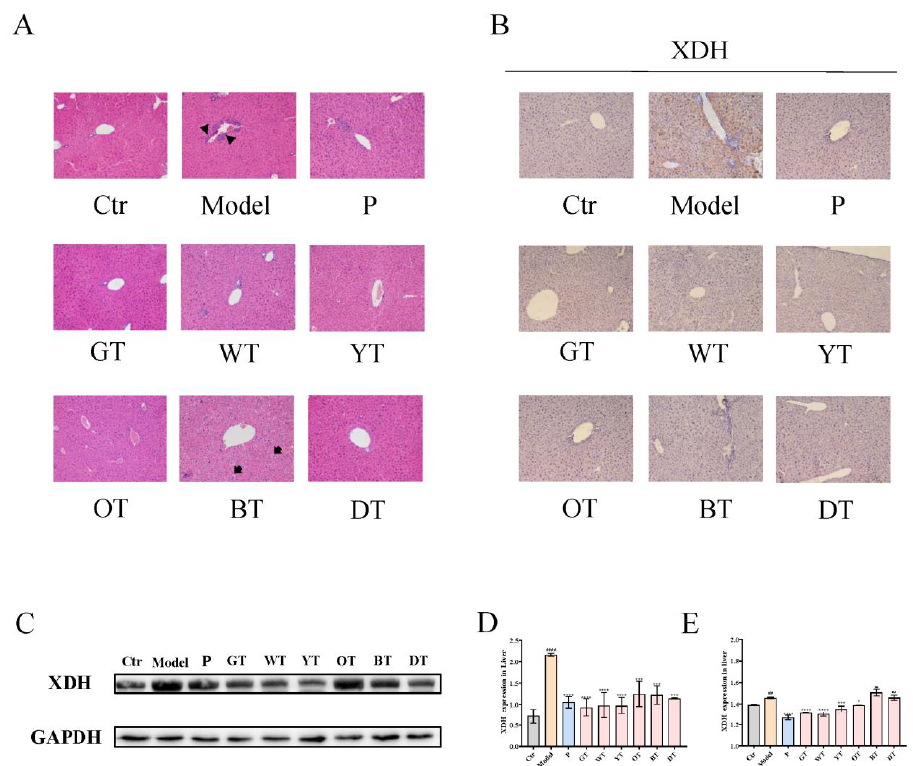
Figure 2. Mechanism of TWEs on UA metabolism in the liver. ( A ) Representative H&E-stained liver tissue images of different treatment groups: triangles indicate inflammatory infiltration and arrows indicate vacuolar degeneration of hepatocytes (200×). Representative IHC ( B ) and Western blotting ( C ) images of XDH expression in the liver. Quantification of XDH expression by Western blotting ( D ) and IHC ( E ). The data are expressed as mean ± SD. ## p < 0.01, #### p < 0.0001 were compared with the control, ns p > 0.1, * p < 0.1, *** p < 0.001, **** p < 0.0001 were compared with the model.